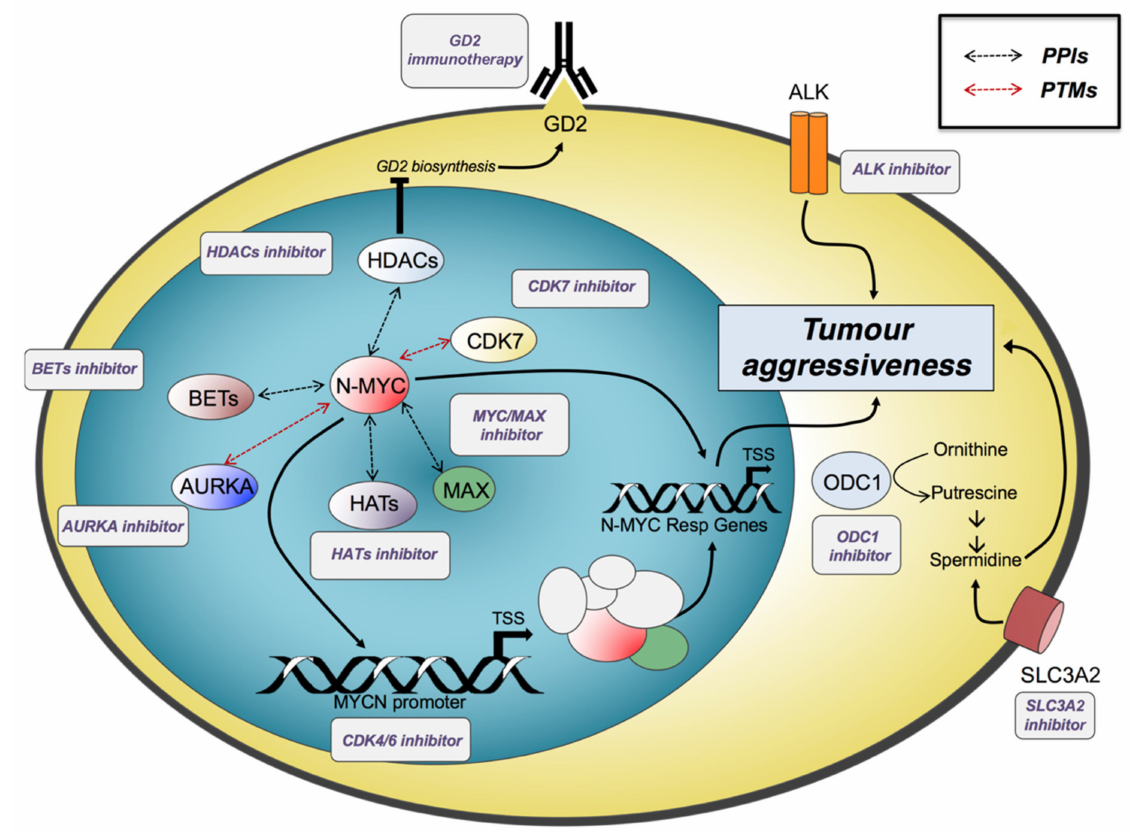
Figure 2. Targeting neuroblastoma oncogenic pathways: N-Myc pathways can be targeted by a direct or indirect approach. Direct targeting can be achieved by blocking the N-Myc/MAX interaction, while indirect targeting can be obtained by inhibiting enzymes involved in N-Myc post-translational modifications (PTMs) or protein–protein interactions (PPIs). Furthermore, HDAC inhibition induces higher expression of GD2, a crucial target for immunotherapy. The N-Myc- responsive gene product ODC1 can be targeted to inhibit spermidine biosynthesis, involved in tumoral aggressive phenotype. Spermidine uptake from the extracellular environment can be blocked by inhibiting the SLC3A2 transporter. ALK inhibitors are successfully used in ALK-mutated